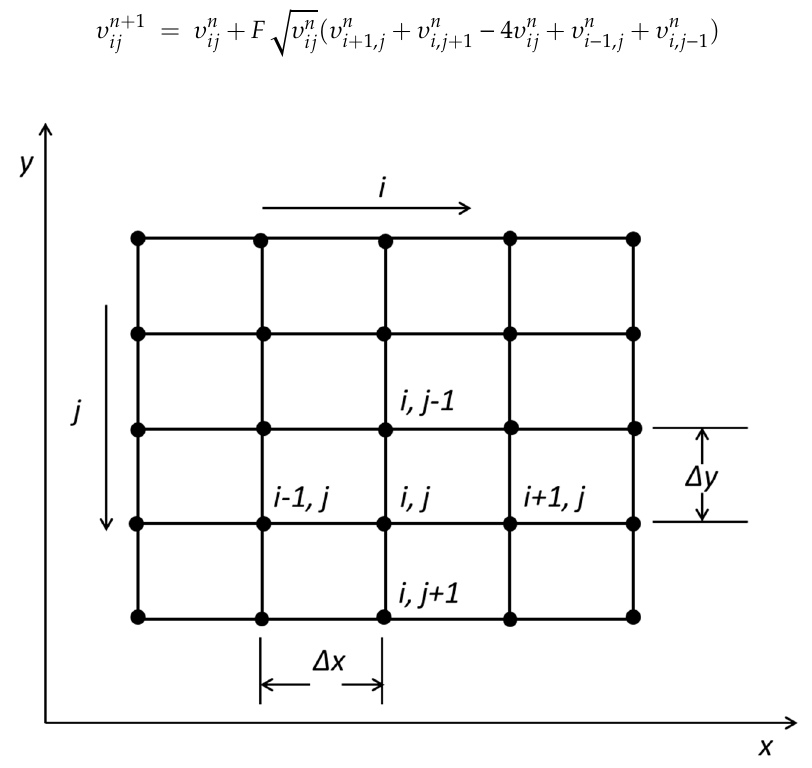
Figure 2. A diagram of the finite difference grid cells.